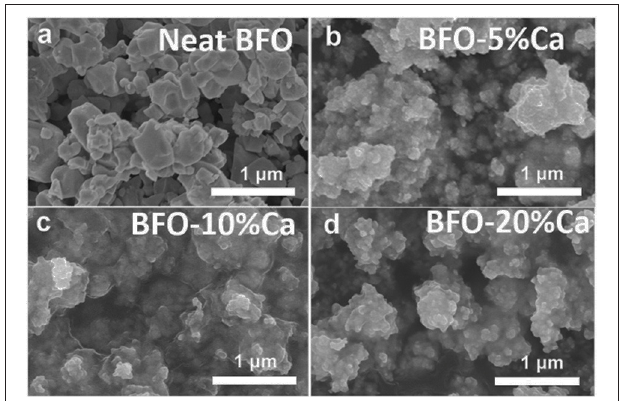
FIGURE 2 | SEM images of (a) neat BFO; (b) BFO-5%Ca; (c) BFO-10%Ca; (d) BFO-20%Ca.